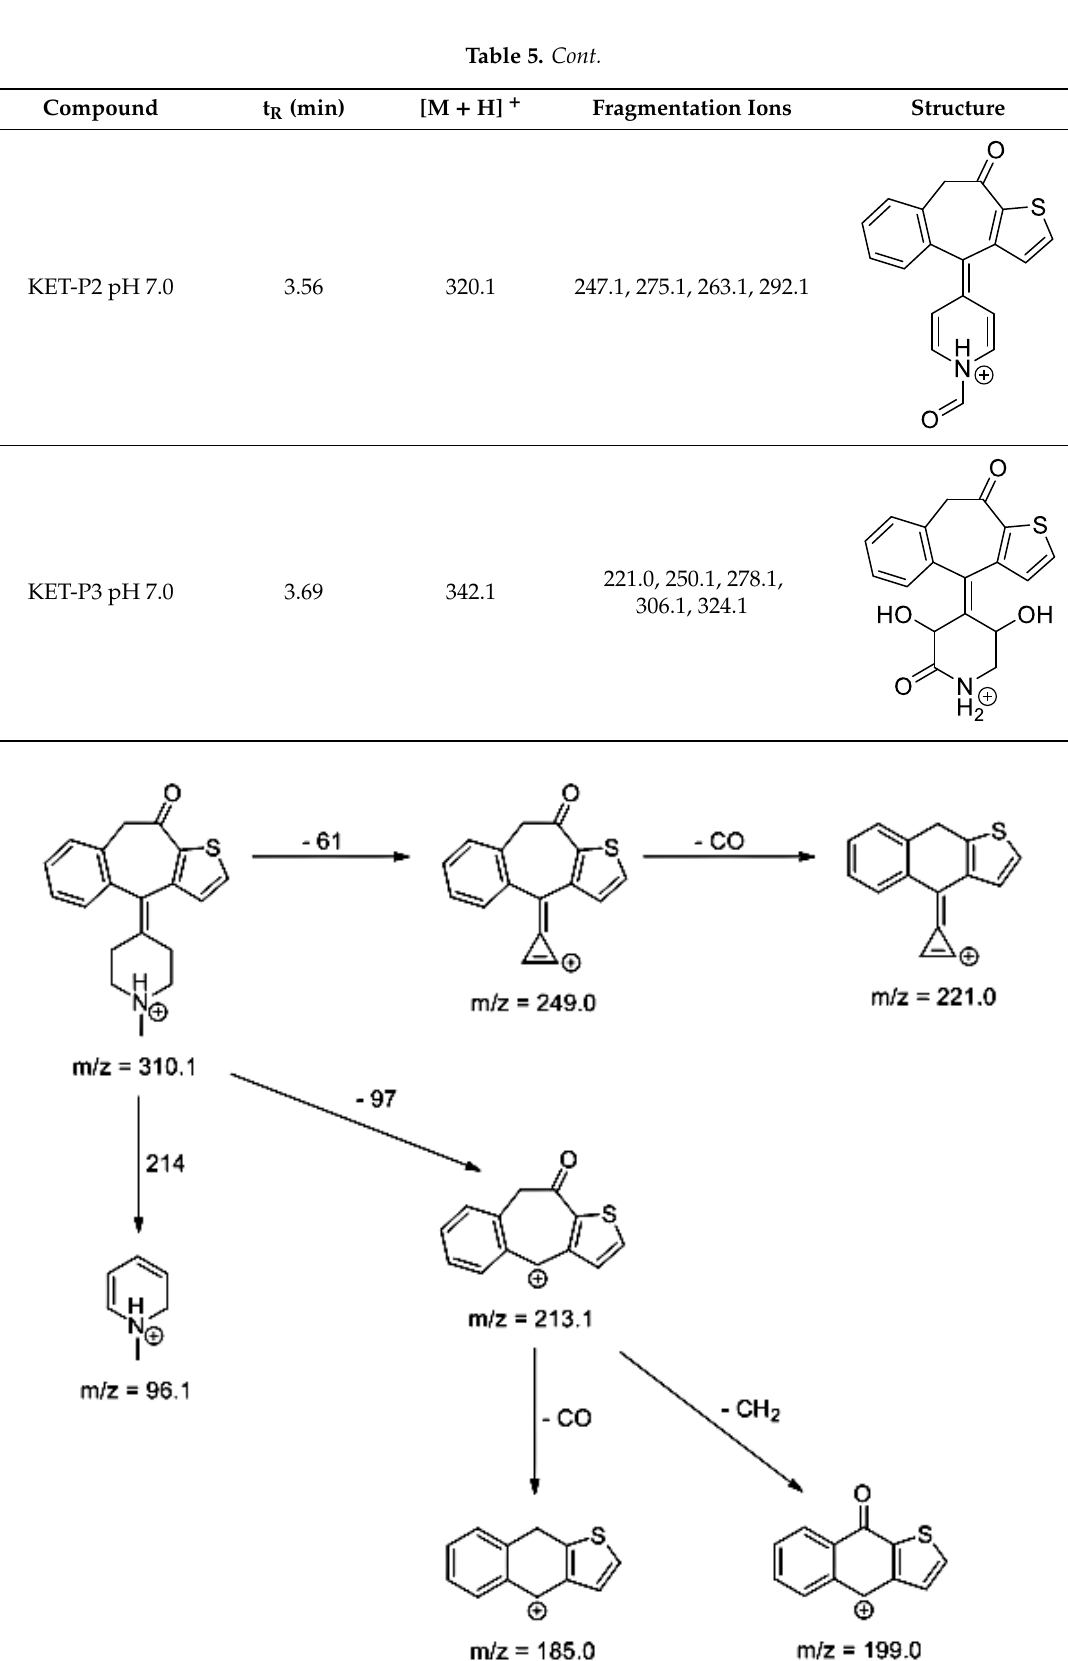
Figure 10. Proposed fragmentation pattern of ketotifen (KET).